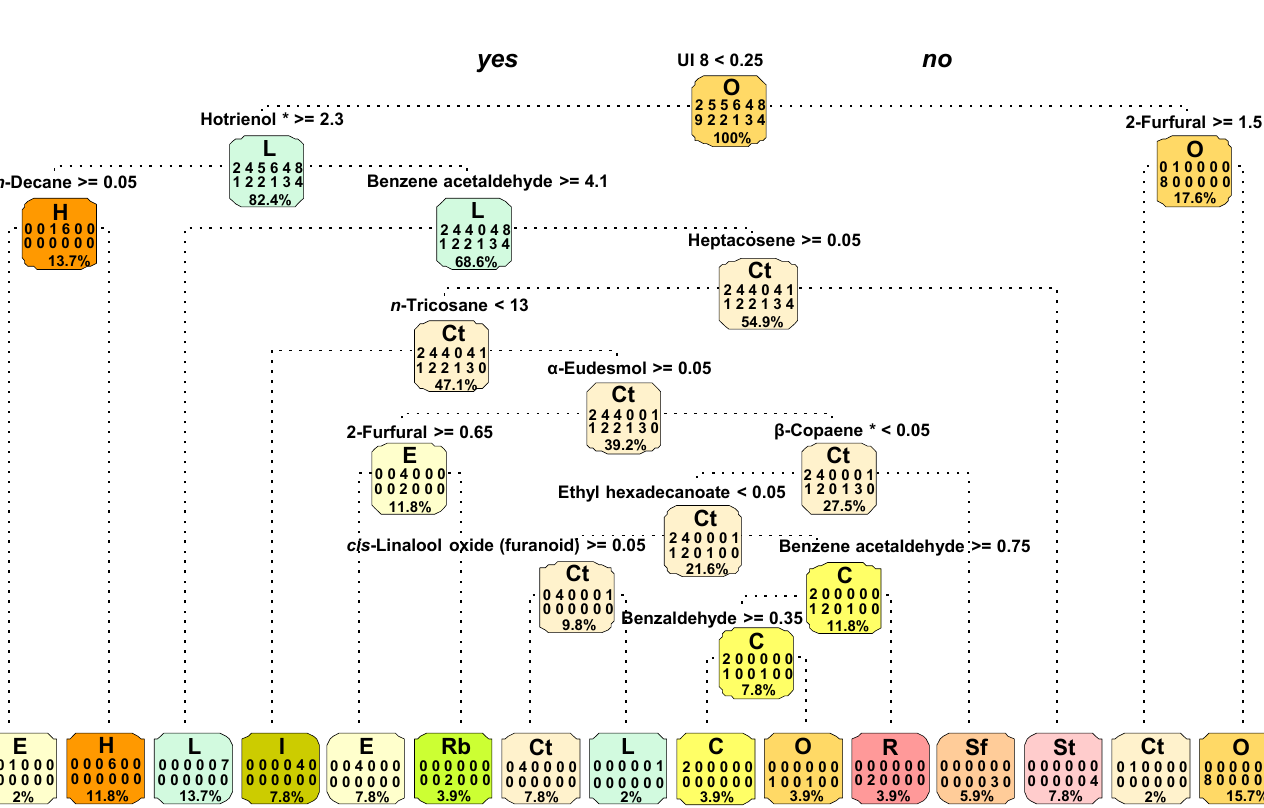
Figure 3. Classification tree with the honey types separated in nodes, according to volatile compounds’ discrimination. * Identification based on mass spectra only. UI: unidentified compounds; C: chestnut; Ct: carob tree; E: eucalyptus; H: bell heather; I: incense. L: lavender; O: orange; R: rape; Rb: raspberry; Sf: sunflower; St: strawberry tree. Nodes should be read as follows: The letter at the top is the node label, corresponding to the most frequent honey type in the node; the numbers represent the number of samples of each of the 12 honey types in the node (honey types in alphabetic order); and in the fourth line is the percentage of honey samples in the node (out of the 51 samples under analysis).